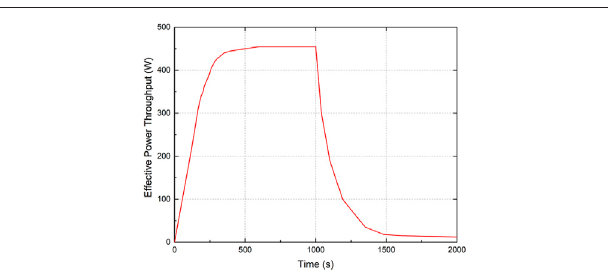
FIGURE 9 | Fitted curve of effective power.